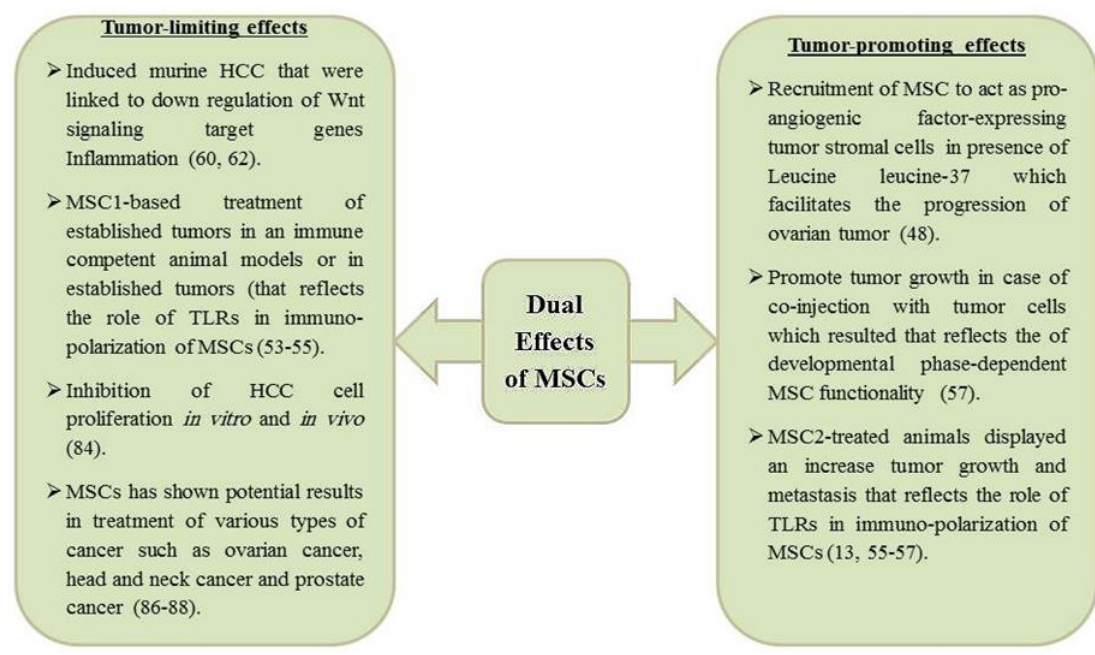
Figure 1. The pleiotropic functionality of mesenchymal stem cells (MSCs) which tumor-limiting and tumor-promoting e ff